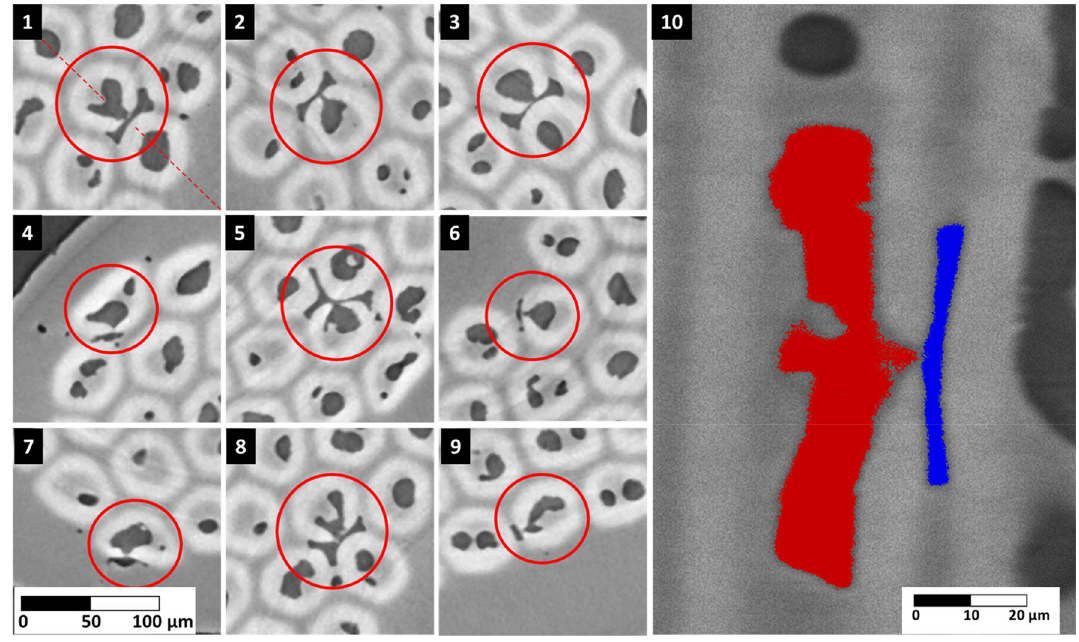
Figure 5. Collection of Cu voids generated by Sn diffusion due to damaged Nb barriers in S20. The void in the sub-element is connected to the Cu void crossing the Nb 3 Sn ring at the Nb barrier rupture. Pictures 1 to 9 are transversal cross sections of the wire. Picture 10 shows the longitudinal cross section of void #1 cut along the red dashed diagonal shown in picture 1. The void is highlighted in red inside the sub-element and in blue in the Cu matrix. The images are obtained from the 3D reconstruction of the X-ray tomographies.